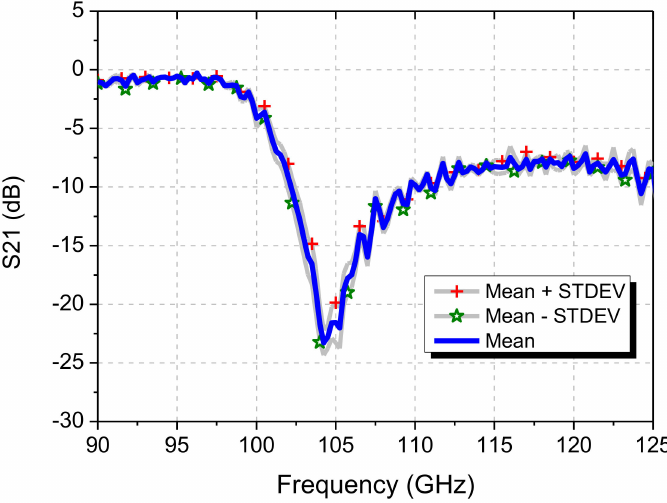
Figure 11. Performance variation of the multiple FSS filter